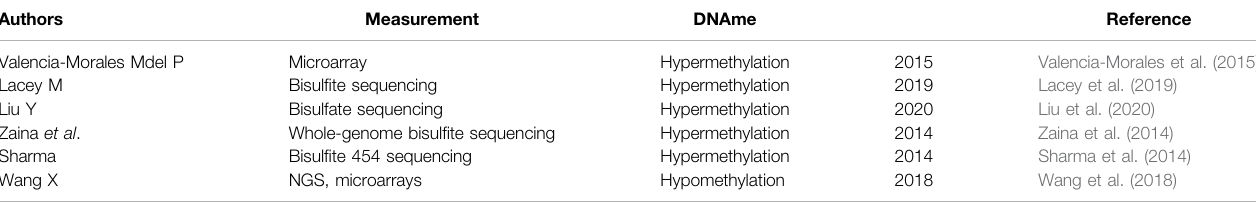
TABLE 1 | Summary of differences in genome-wide methylation in AS.